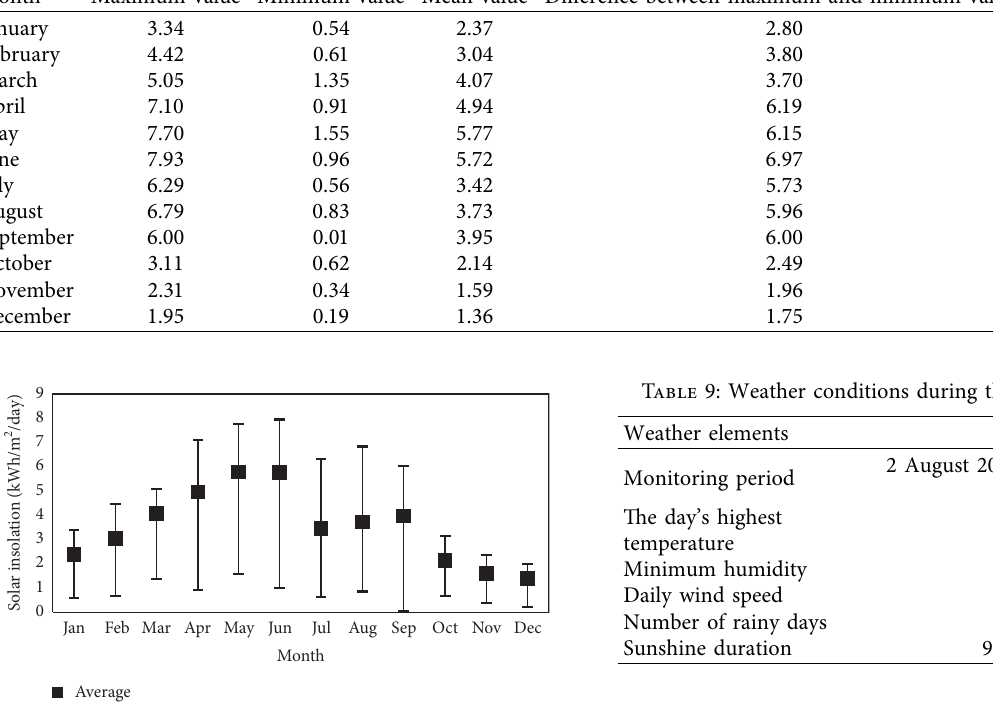
Table 8: Range of measured solar insolation (unit: kWh/m 2 /day). Month